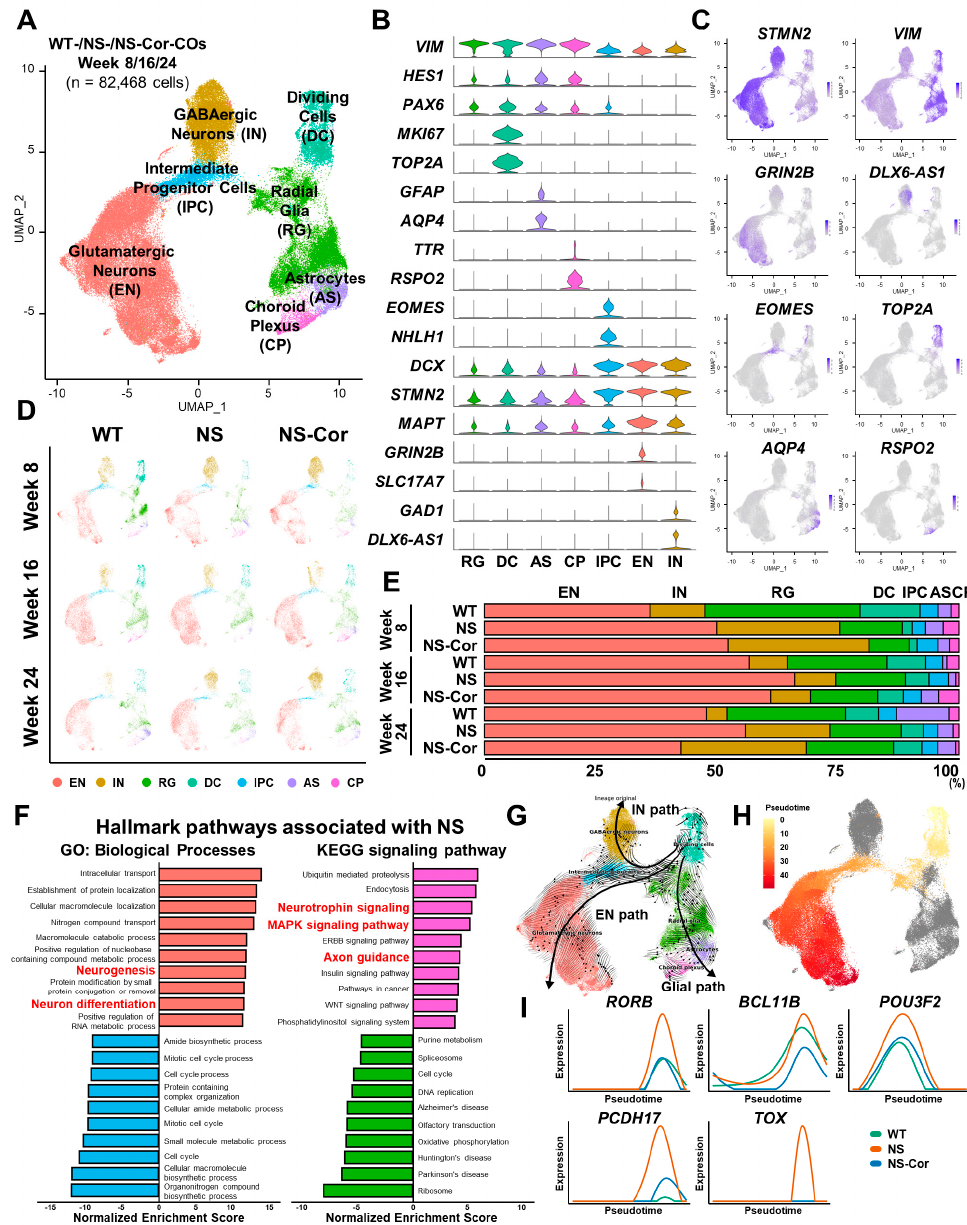
Figure 2. Single-cell transcriptomic analyses of COs. ( A ) UMAP plot of a total of 82,468 cells obtained under nine distinct experimental conditions (WT-/NS-/NS-Cor-COs, Week 8/16/24). Clusters were annotated into seven different cell types based on the expression of the cell type-specific genes. ( B ) Transcriptional expression of representative lineage- and cell type-specific genes in each cluster. ( C ) Distribution of cells expressing representative lineage- and cell type-specific genes in UMAP space. ( D ) Cell type distribution of COs according to the experimental conditions. ( E ) Proportions of cell types in the respective CO-groups. ( F ) Gene Ontology analysis of the top 10 hallmark pathways significantly enriched or reduced in NS-COs. ( G ) RNA velocity of COs. Three developmental pathways are depicted on the UMAP. ( H ) Pseudotime trajectory of cells lining the EN pathway. ( I ) Transcriptional expression of diverse cortical layer marker genes along the pseudotime.